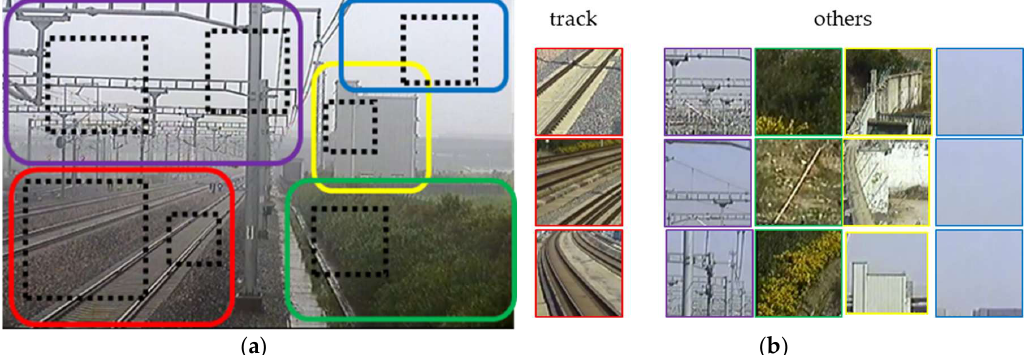
Figure 8. Collecting samples of local areas for CNN training. ( a ) Solid-line rectangles are delineated by manual with labels, including the track area (red), sky (blue), catenary system (purple), green belt (green), ancillary buildings (yellow). The dotted-line boxes are extractor windows. ( b ) The dataset containing two categories for training the CNN.